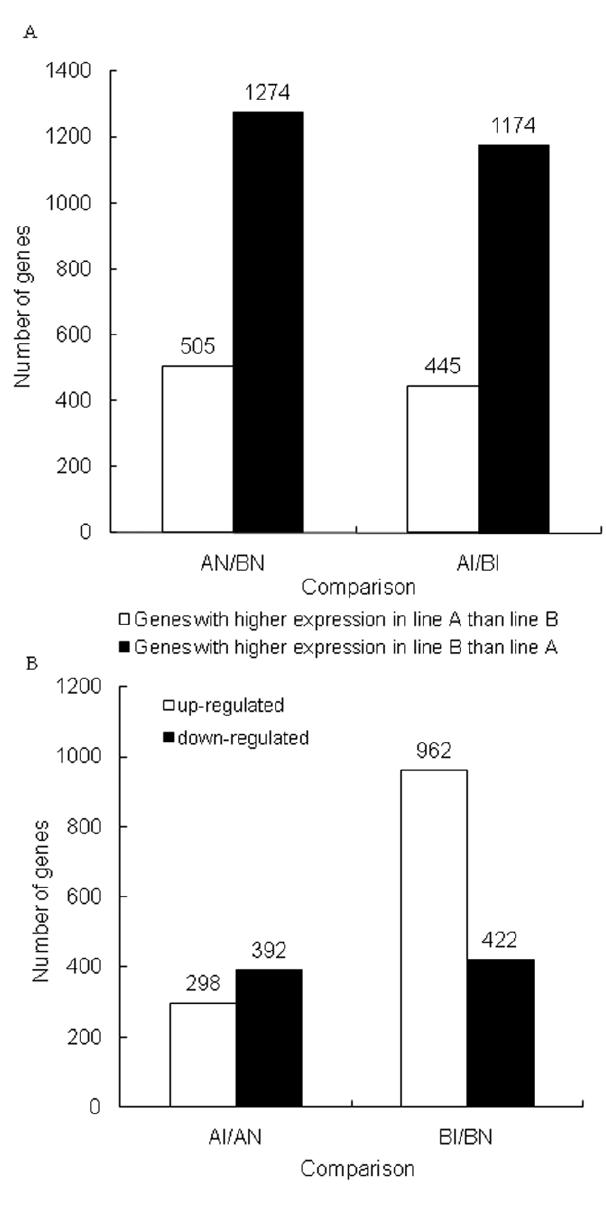
Figure 1. Number of significantly differentially expressed genes between comparisons. A: Number of genes with higher expression in one line (A or B) than the other line (B or A) when comparing between lines A and B. White bar represents number of genes with higher expression in line A than line B; Black bar represents number of genes with higher expression in line B than line A. B: Number of up and down-regulated genes following C. jejuni inoculation within each line (A or B) when comparing inoculated with non-inoculated control chickens. White bar represents number of up-regulated genes; Black bar represents number of down-regulated genes.